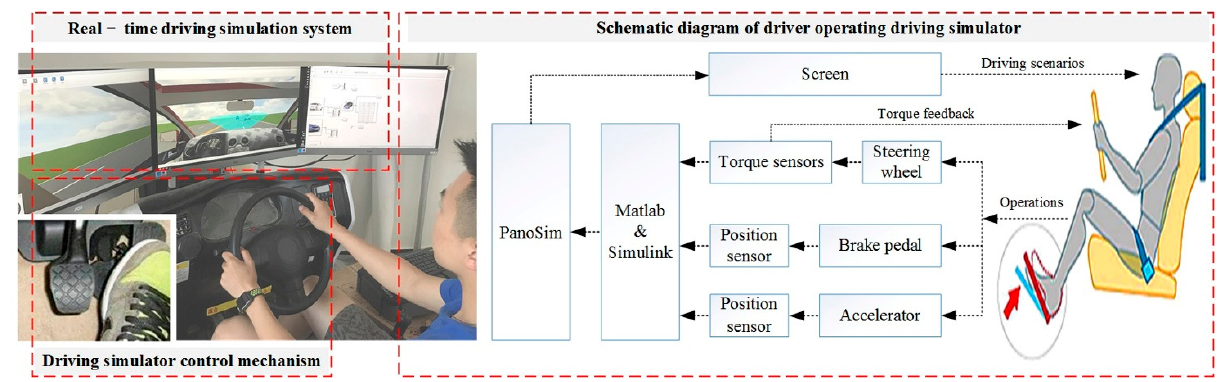
Figure 2. The process of experimental data collection based on the driving simulator .